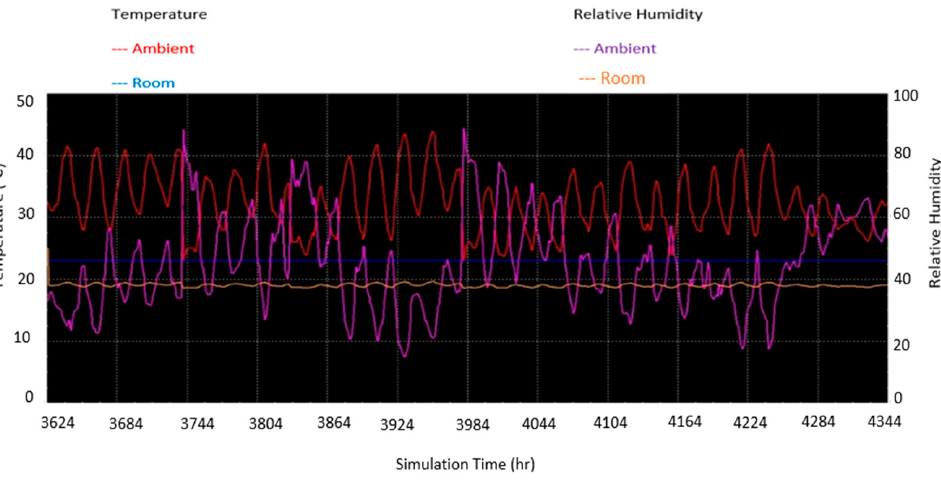
Figure 11. June simulation run for configuration A.